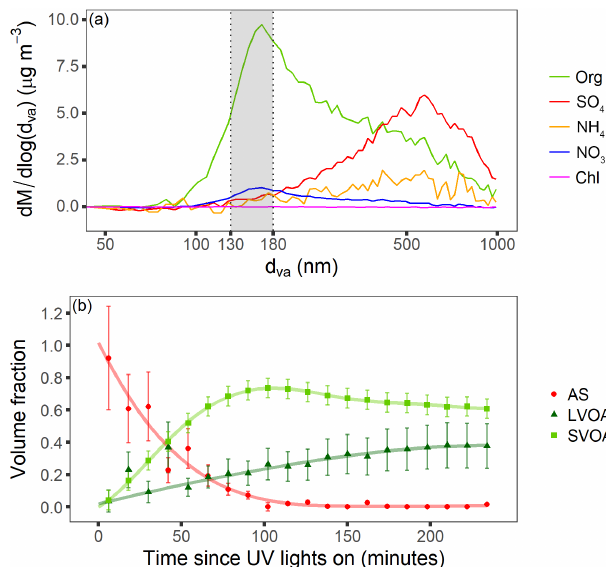
Figure 5. (a) Mean size distribution of the major compositional species measured by the AMS, observed over 4h of SOA conden- sation and ripening. The shaded region represents the approximate d va range for particles with d m = 100nm. (b) Relative volume con- tributions of AS, LVOA and SVOA for aerosol in the selected d va range. The curves are fitted splines to guide the